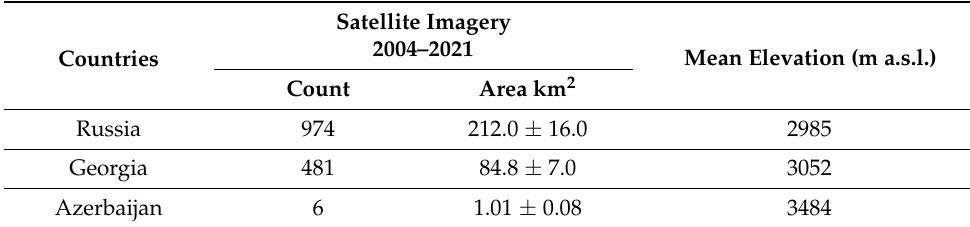
Table 3. The distribution of rock glaciers in the Greater Caucasus according to countries, ordered by count.